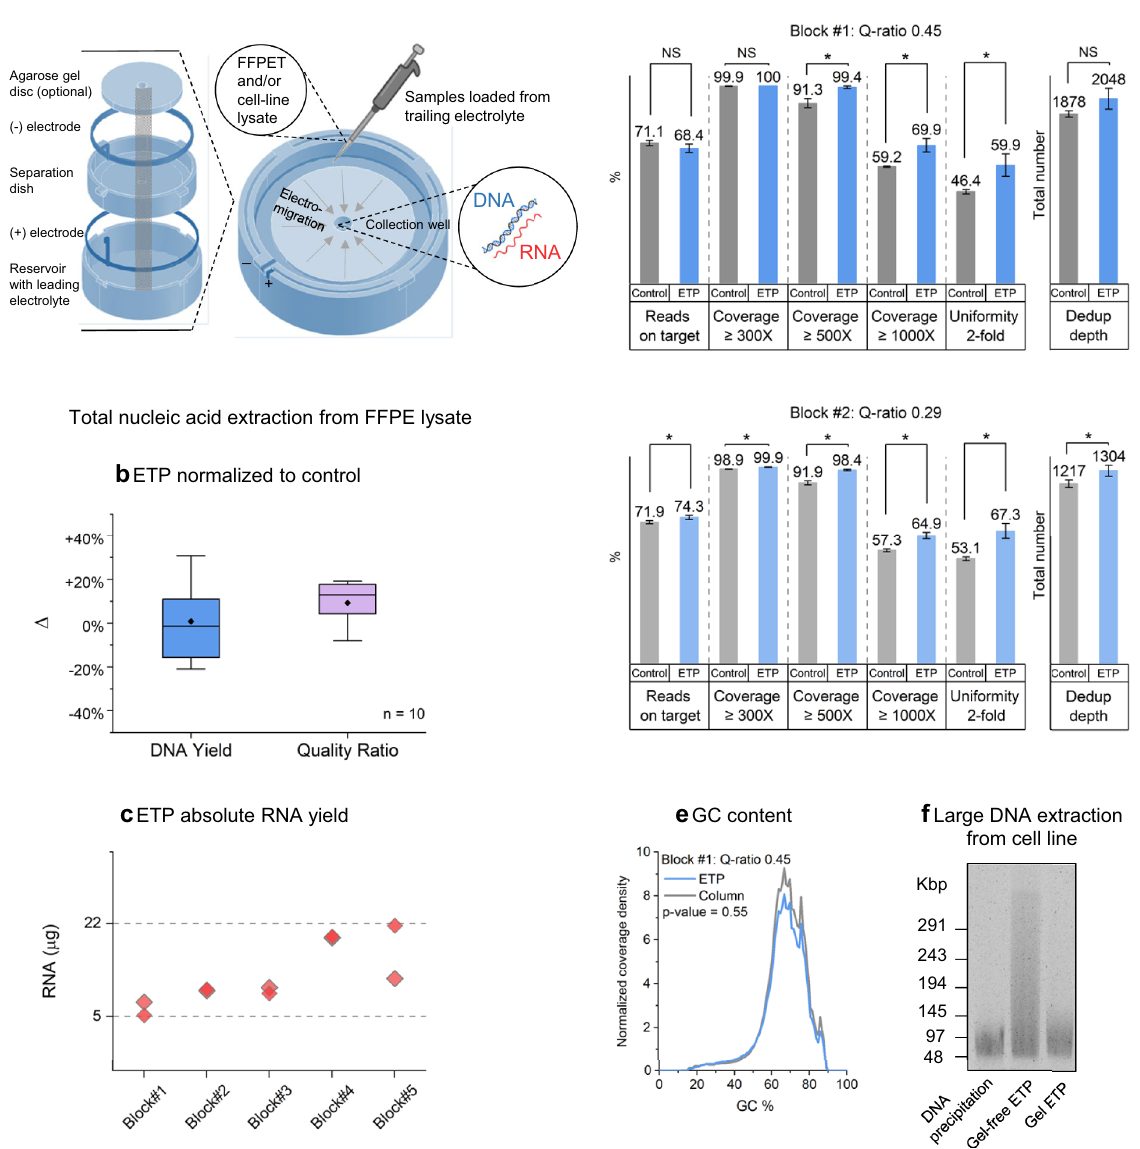
Figure 1. Epitachophoresis total nucleic acid extraction. ( a ) Exploded view of ETP device components. ETP device schematic, sample lysate injection and extract collection indicated. ( b , c ) Total nucleic acid extraction from FFPE tissue lysate. Two extraction replicas per method for five CRC FFPE blocks (n = 10). ( b ) Box plots of ETP DNA normalized to FFPE DNA column clean-up. Blue box—Qubit yield. Purple box—qPCR Quality ratio. ( c ) Scatter plot of ETP RNA Qubit yield (n = 10). ( d , e ) FFPE DNA Sequencing using AVENIO Tumor Tissue Targeted Kit. FFPE DNA column clean-up kit extracts were used as control to ETP extracted DNA. ( d ) Reads mapped on Target, Coverage (300X, 500X, 1000x), Uniformity, Total dedup depth. Quality block #1 Q-ratio 0.45 and quality block #2 Q-ratio = 0.29 (n = 4). ( e ) GC content of FFPE sequenced libraries (ETP—blue line, Control—grey line). ( f ) Pulse field gel electrophoresis of DNA extract from Lung Adenocarcinoma cell line (NCI-H1975). Line 1—Wizard ® Genomic DNA Purification Kit, Line 2 Gel-free ETP, Line 3 Gel Supplementary Fig. S3). For block 1 (Q-ratio = 0.45), AVENIO DNA targeted enrichment libraries from ETP extraction had similar dedup-depth and on-target rates and superior somatic targets coverage (500x and 1000x), a highly desirable feature. Whereas, in block 2 (Q-ratio = 0.29), all the DNA sequencing metrics were better for ETP samples compared to control. In summary, ETP was capable of extracting high quality DNA from a low quality material. We also looked into ETP’s ability to extract large molecular weight DNA. Gel ETP and a non-sieving (gel-free) ETP condition were used to extract DNA from lung carcinoma cell line (NCI-H1975). A DNA precipitation kit (Promega Wizard HMW DNA) was used as a reference. Pulsed-field gel electrophoresis was employed to estimate